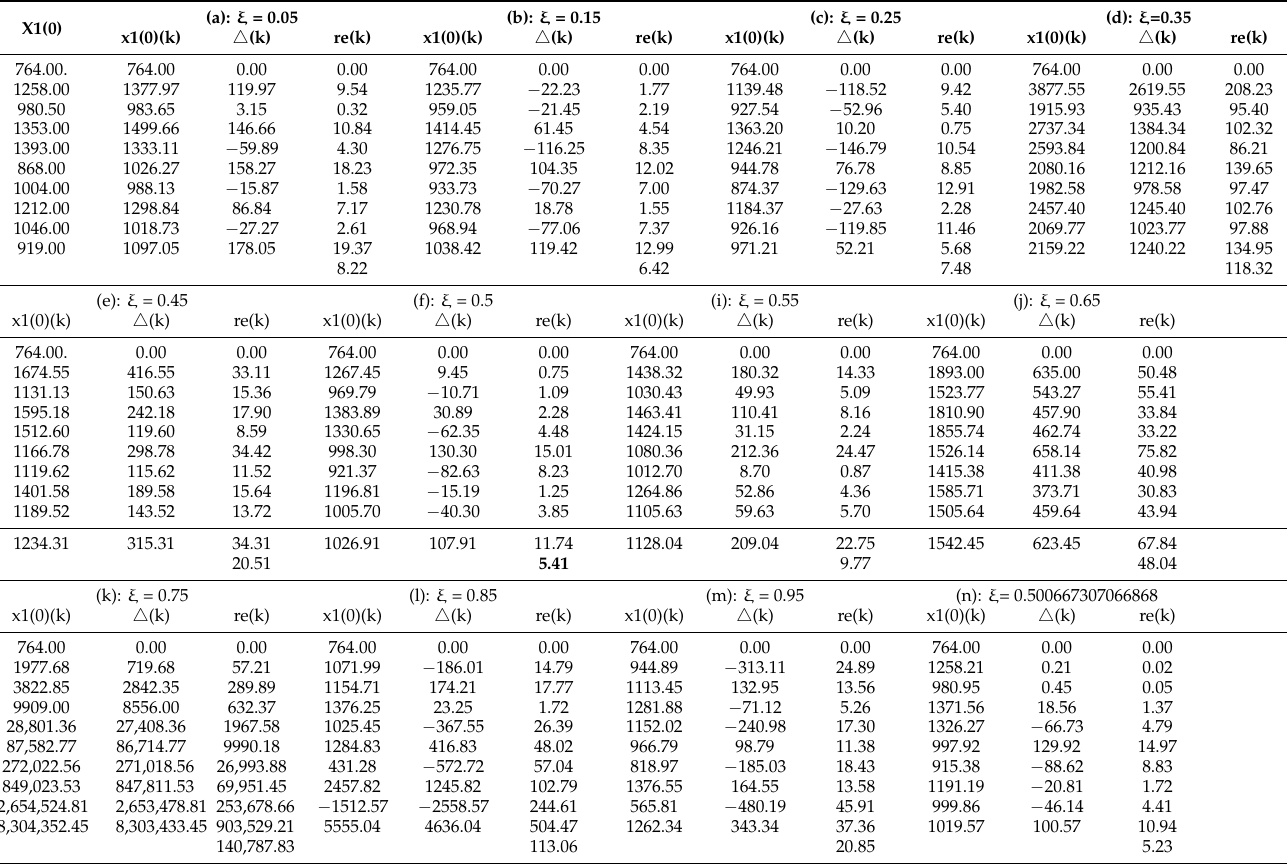
Table 6. POBGM (1,5) model results with different background-value coefficients (0.05–0.95 with 0.1